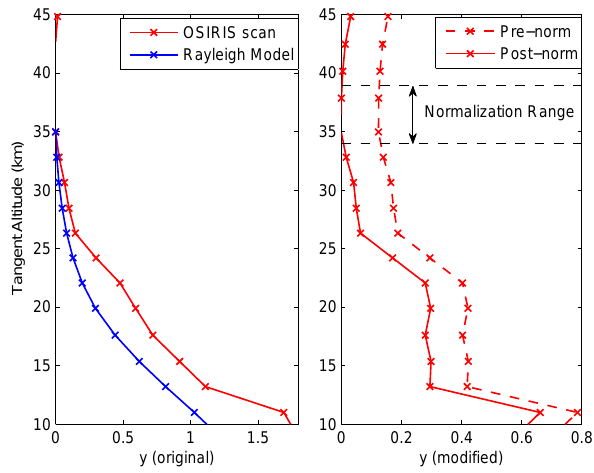
Fig. 1. The stratospheric aerosol retrieval vector, y . The left panel shows y as calculated according the original algorithm for a typi- cal OSIRIS scan in red as well as y for a model calculation of an aerosol-free atmosphere in blue. The right panel shows the modi- fied version of y , before and after the normalization (with dashed red and solid red lines according to Eqs. (4) and (5)